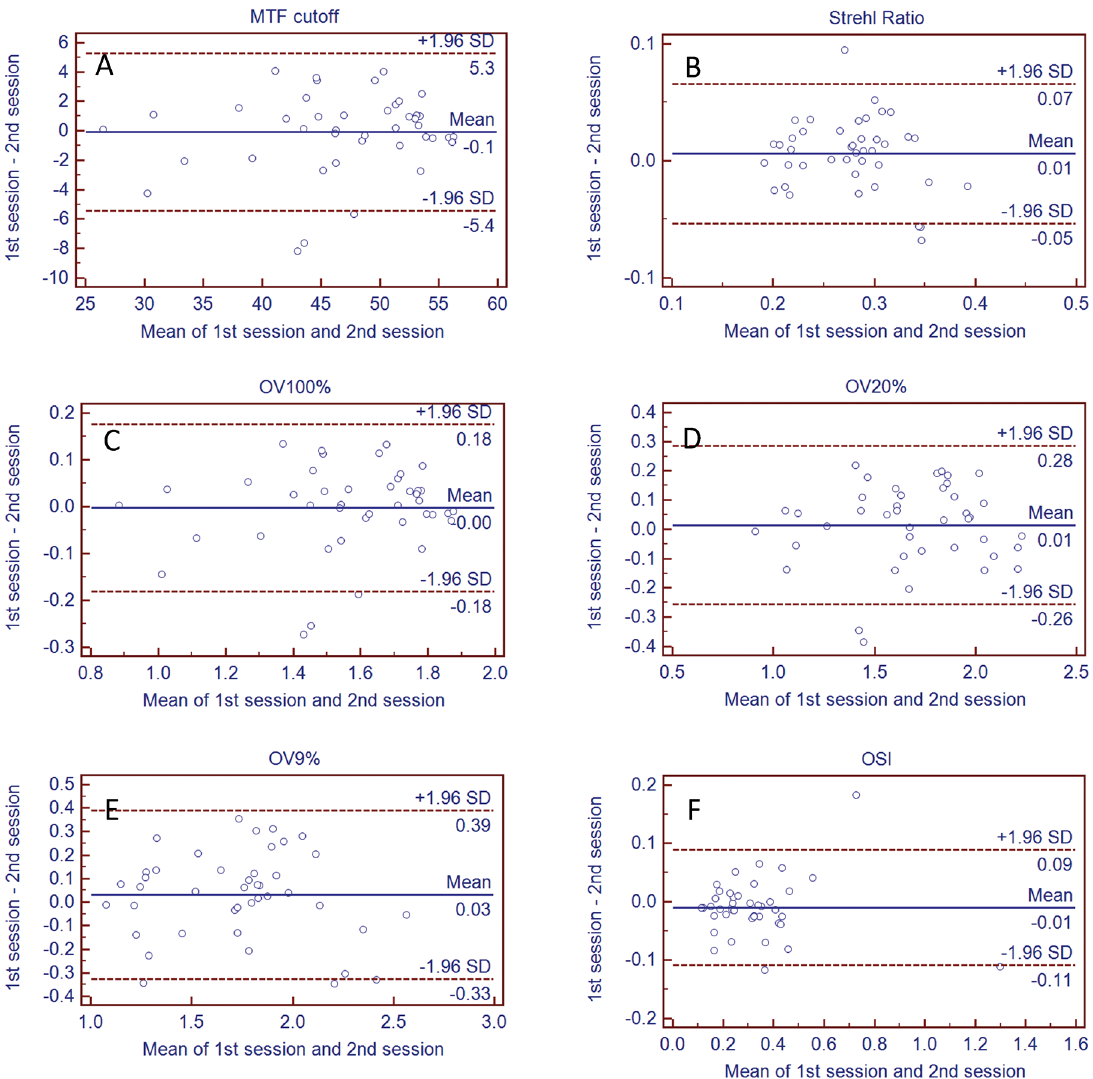
Fig 1. Bland-Altman plots of all parameters between the first and second session. Bland-Altman plots of the mean difference (Md) and 95% confidence intervals (CI) for MTF